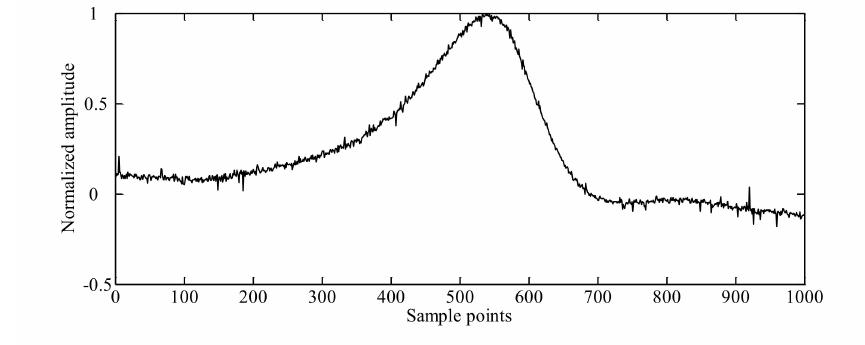
Figure 13. Normalized weak magnetic signals of the rope fatigue defect before and after noise